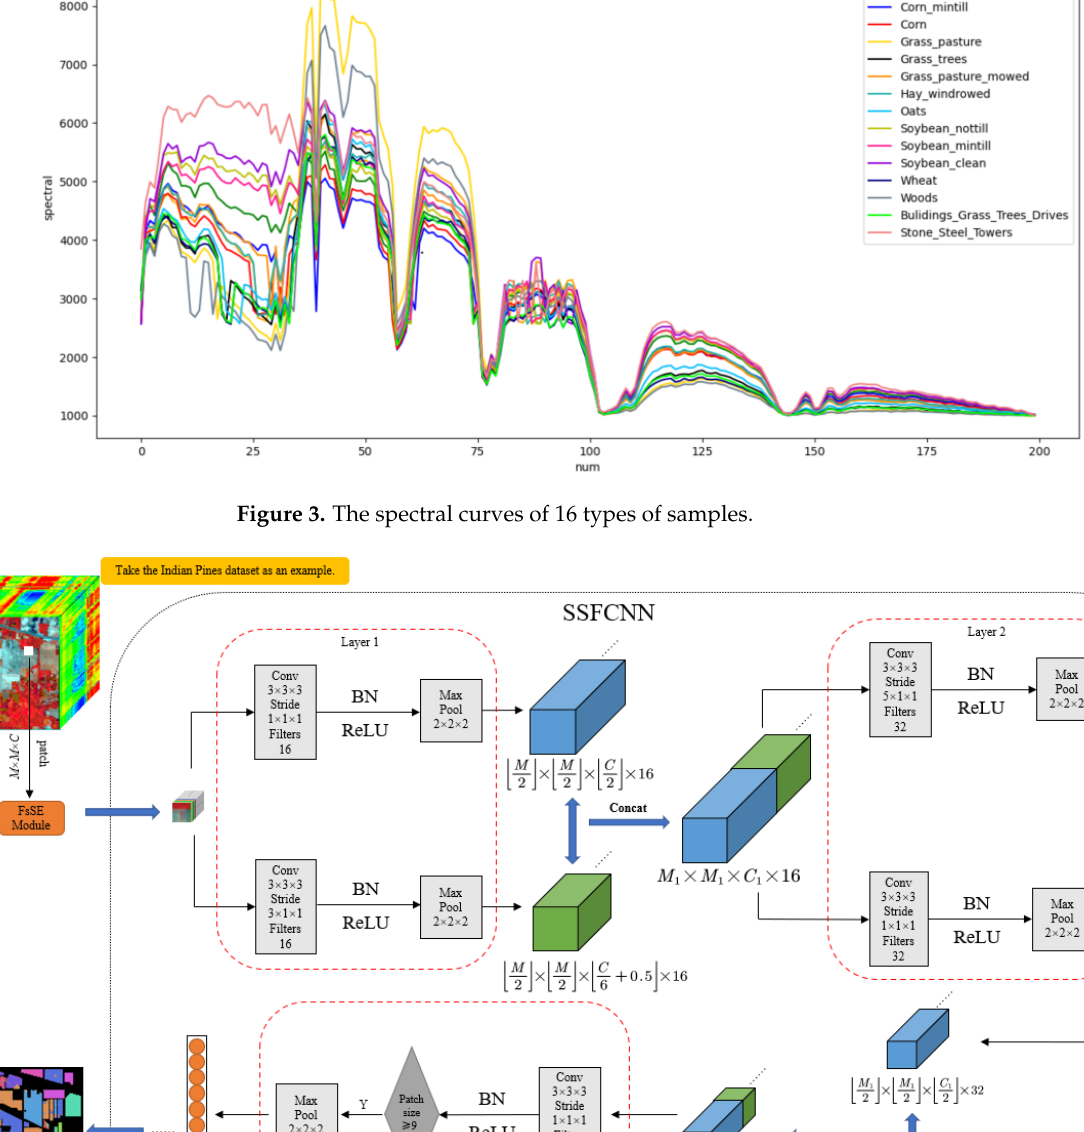
Figure 3. The spectral curves of 16 types of samples.